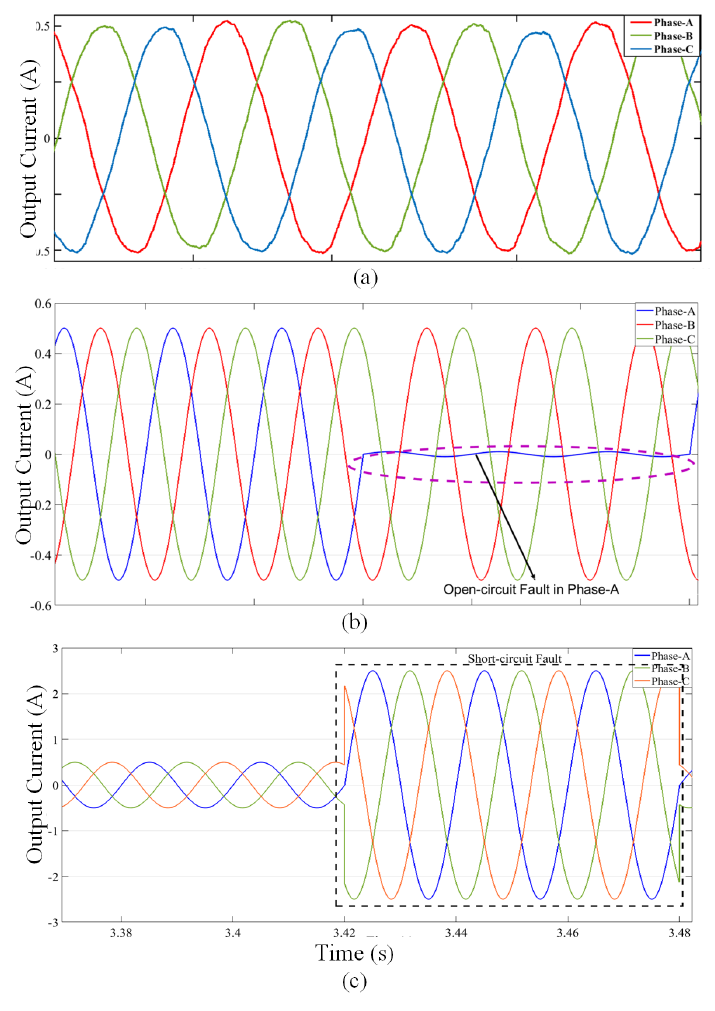
Figure 7. Simulation results of output current: ( a ) Normal operation, ( b ) open-circuit fault, and ( c ) short-circuit